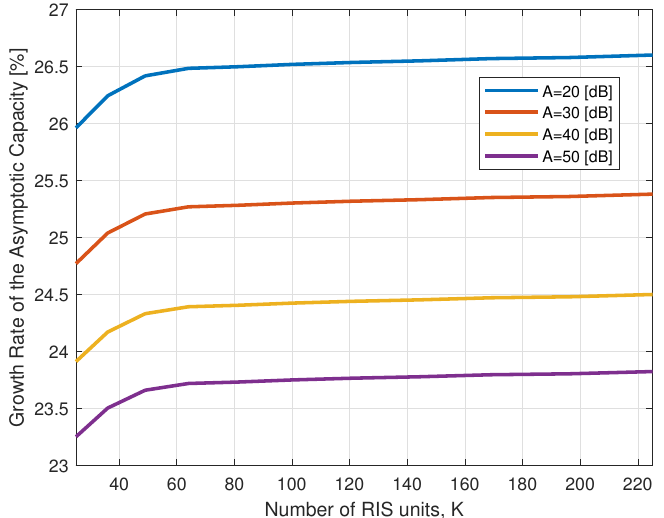
Figure 4. Asymptotic capacity versus the number of RIS with the optimal assignment